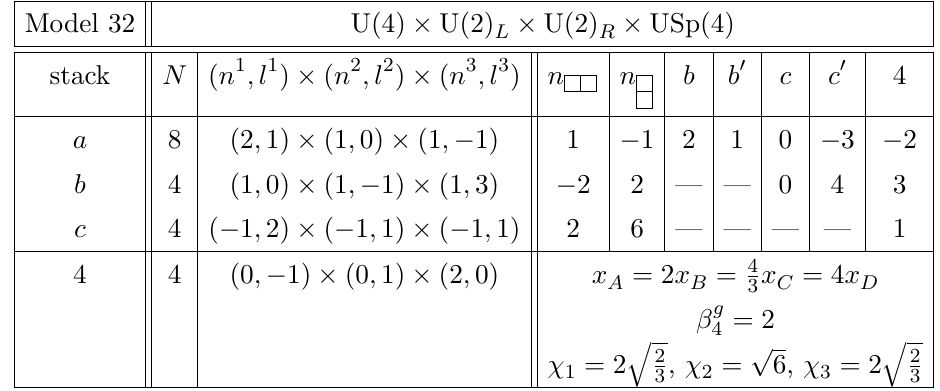
Table 39 . D6-brane configurations and intersection numbers of Model 32, and its MSSM